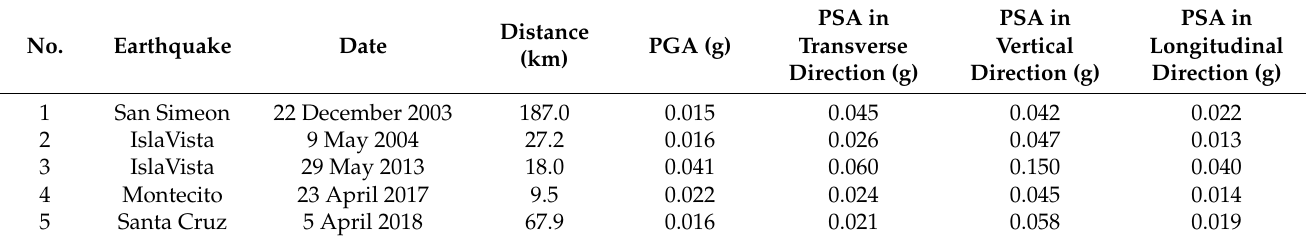
Table 1. Earthquake records considered in this study.